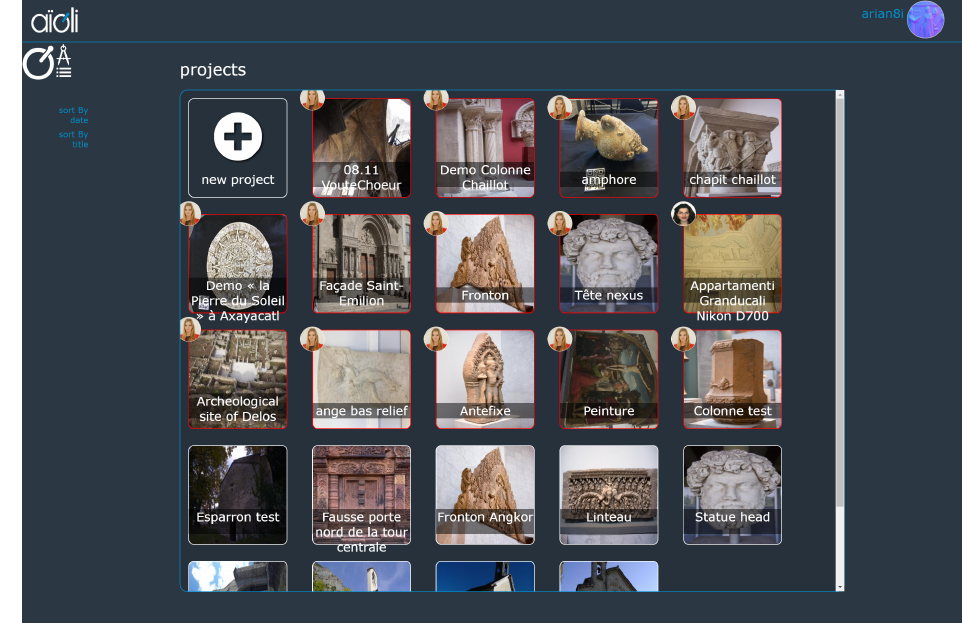
Figure A1. Current screenshot of AIOLI user’s workspace showing the diversity of data sets processed by